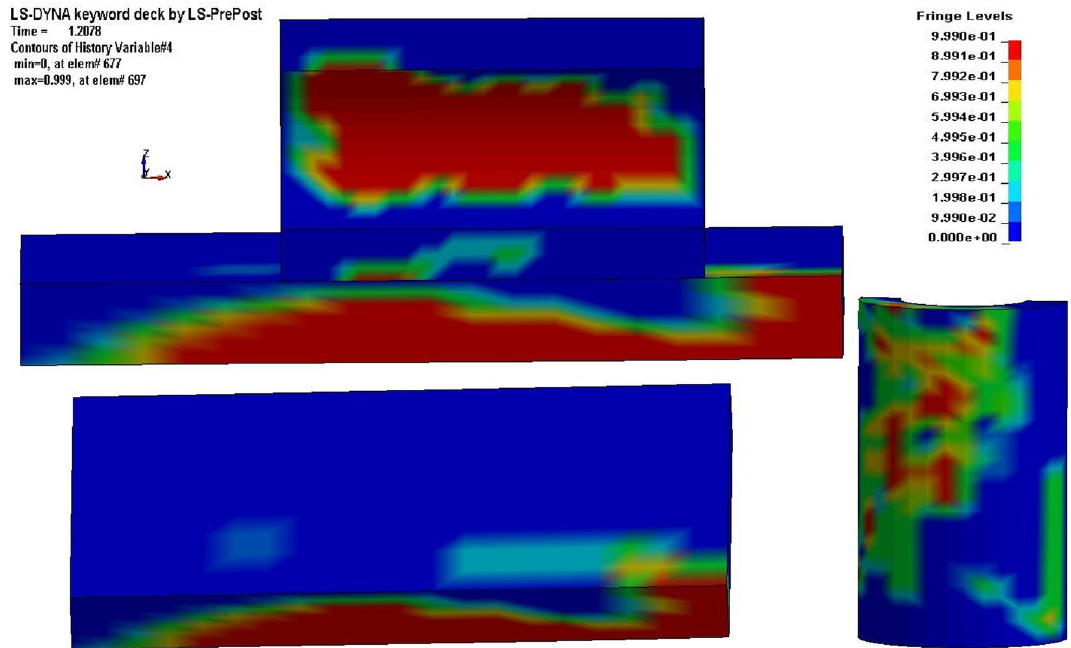
Fig. 25 Contours of brittle damage at the time of